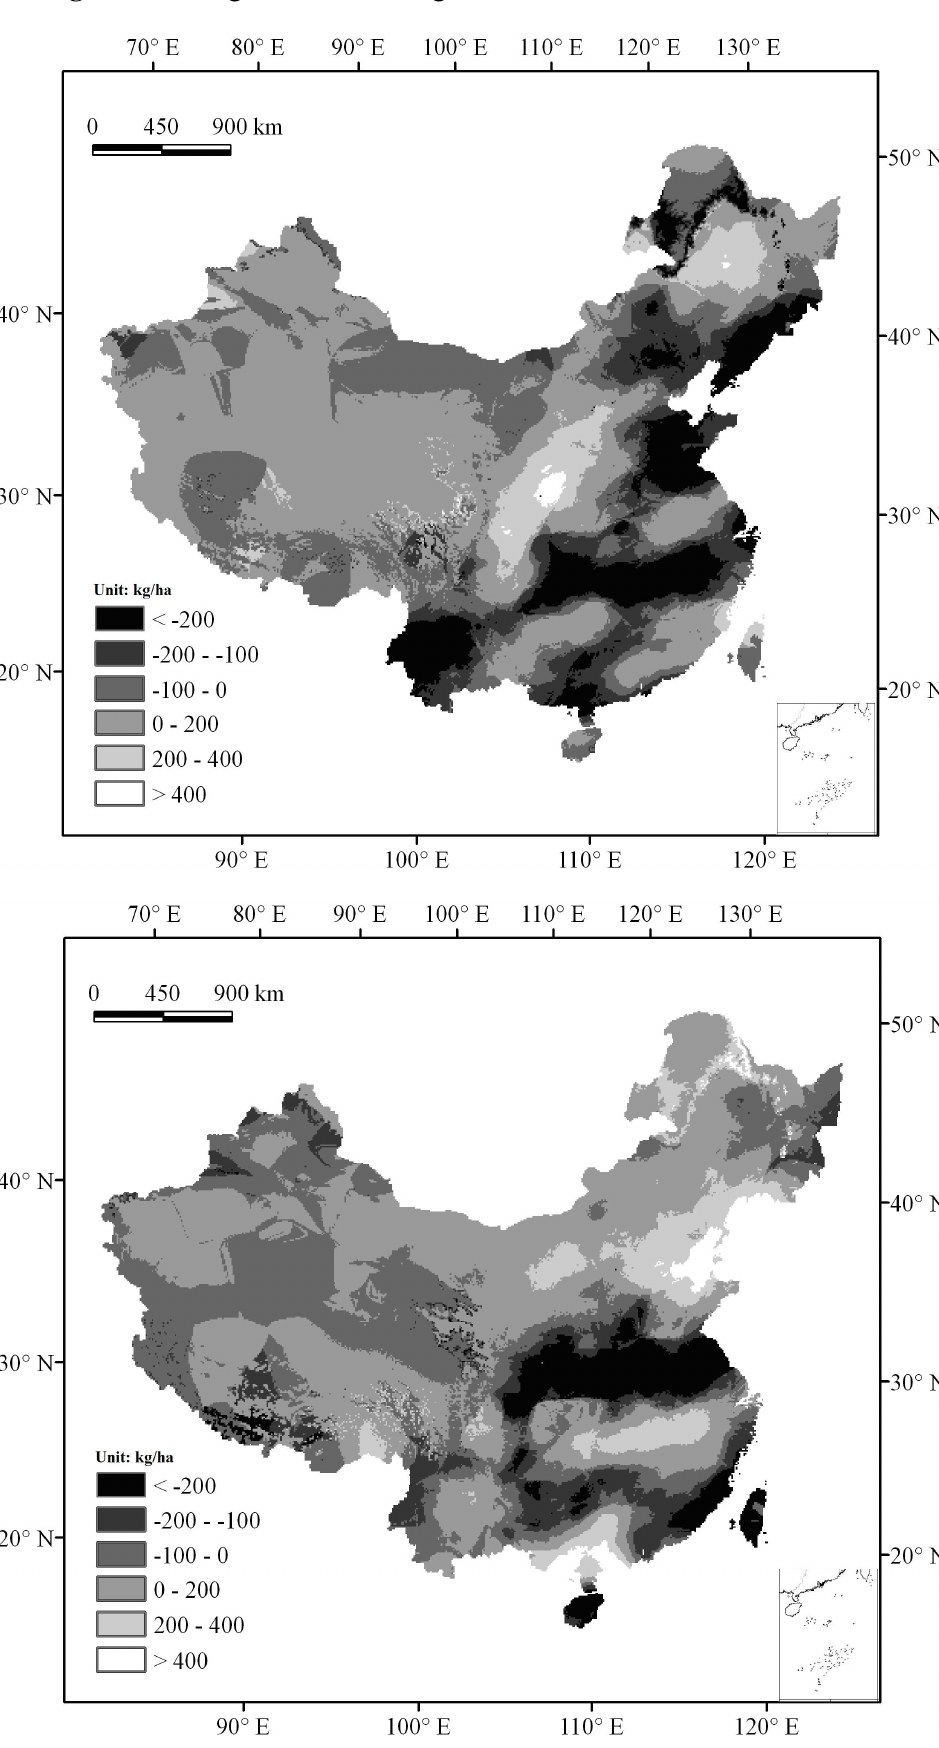
Figure 1. Changes in NPP during 1988–1995 and 1995–2000 in